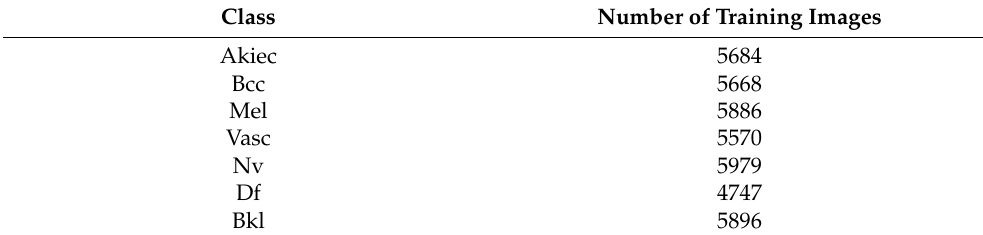
Table 2. A balanced dataset resulting from applying Augmentation (oversampling) techniques. As part of the data expansion, segmented photos were included.